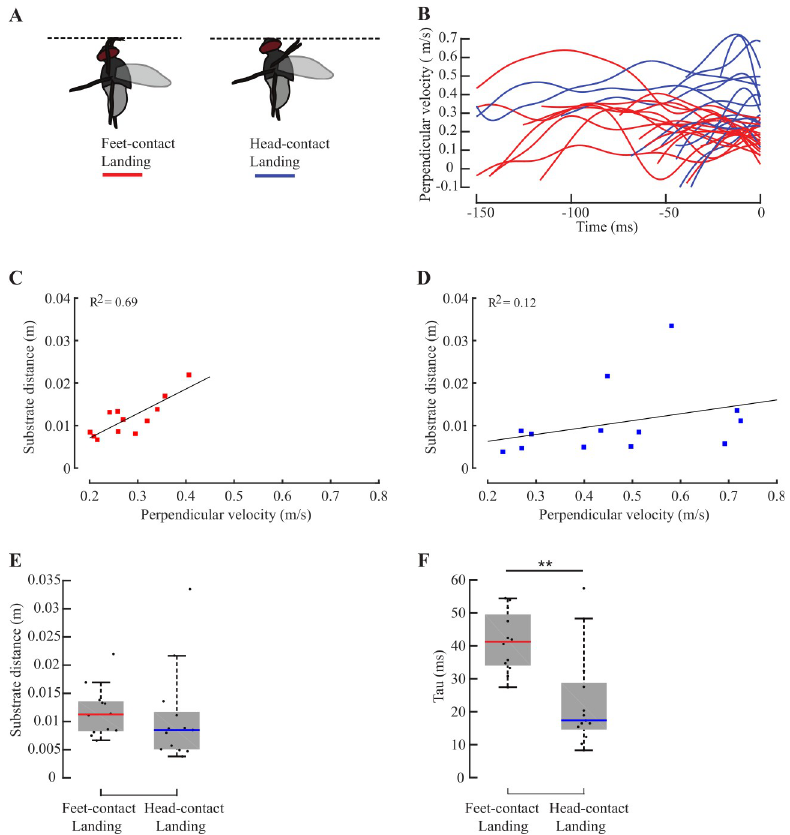
Fig 3. Onset of deceleration for flies performing feet-contact and head-contact ceiling landings. (A) Ceiling landings were grouped into head-contact landings (n = 15, blue) vs. feet-contact landings (n = 17, red) (B) Perpendicular velocity versus time-to-collision for all trials (n = 32) (C-D) 25 out of 32 flies decelerated before landing (see Materials and methods), and were analyzed further. Of these 25 ceiling landings, 12 performed a feet-contact landing and 13 flies executed a head-contact landing. (C) Substrate distance versus perpendicular velocity at the onset of deceleration for inverted feet-contact landings (n = 12, R 2 = 0.69). (D) Substrate distance versus perpendicular velocity at the onset of deceleration for inverted head-contact landings (n = 13, R 2 = 0.12). (E-F) Box plots for (E) substrate distance, and (F) tau , at the onset of deceleration for feet-contact and head-contact landings (Grey boxes indicate the central 50% data around the median (center line)). Whiskers represent 1.5 times interquartile range. Outliers were included in the analysis. Asterisks represent statistically different comparisons ( � , �� , ��� , and ���� represent p < 0.05, p < 0.01, p < 0.001, p < 0.0001 respectively). These conventions are used in all subsequent